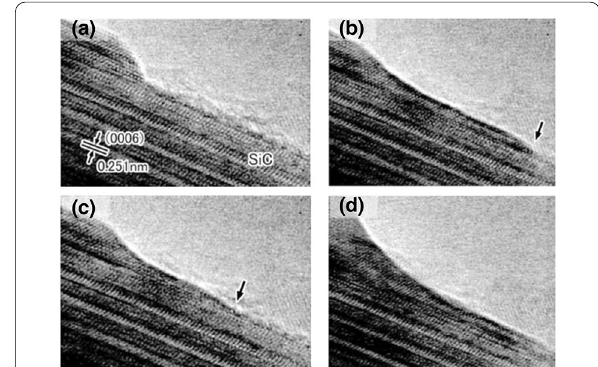
Figure 6 High-resolution images of tip of spreading molten alloy captured at approximately 800 °C: ( a ) 0.0 s, ( b ) 3.2 s, ( c ) 4.4 s, ( d ) 7.8 s [36]